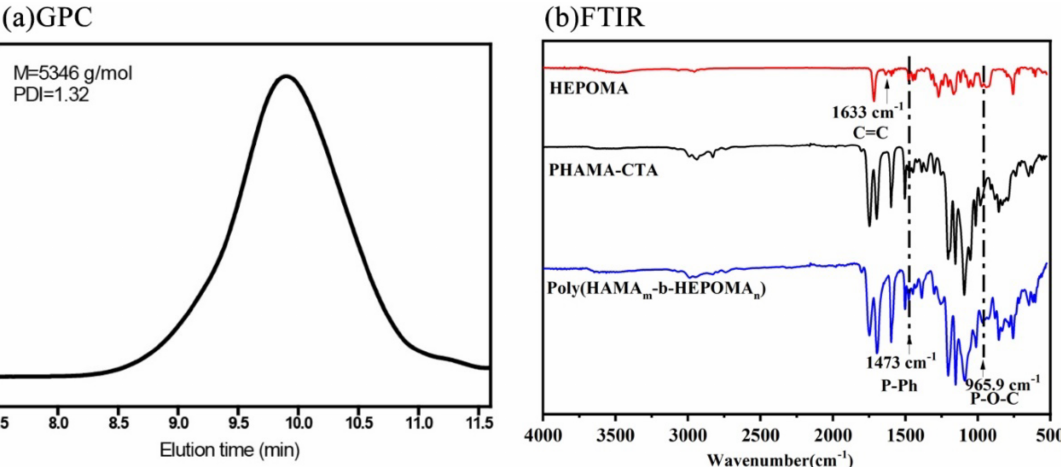
Figure 1. ( a ) The GPC of HAMA-CTA, ( b ) FTIR spectra of HEPOMA, PHAMA-CTA and poly(HAMA m -b-HEPOMA n